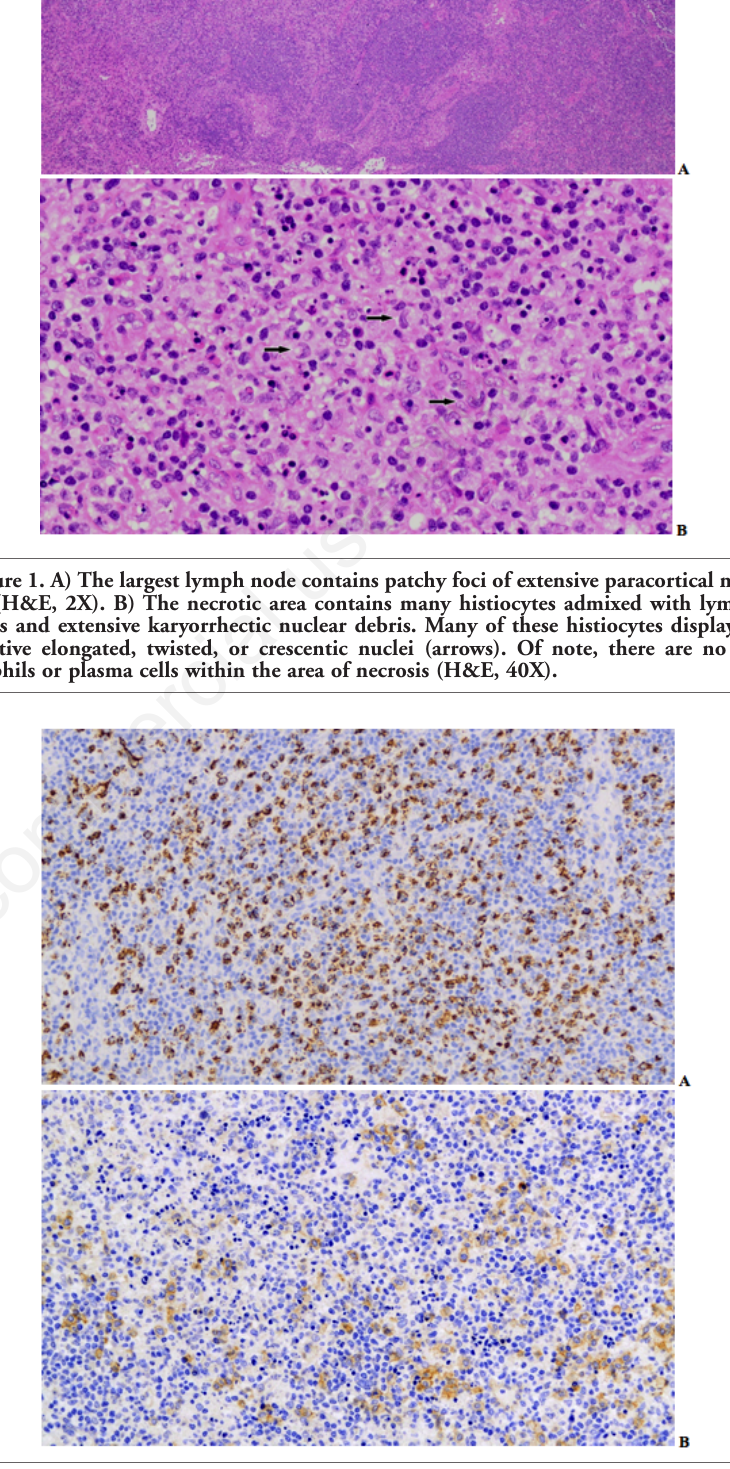
Figure 2. A) Histiocytes in the necrotic areas stain strongly for CD163 (Immunostain, 10X). B) CD123 staining identifies plasmacytoid dendritic cells infiltrating the margin of the necrotic focus (Immunostain,